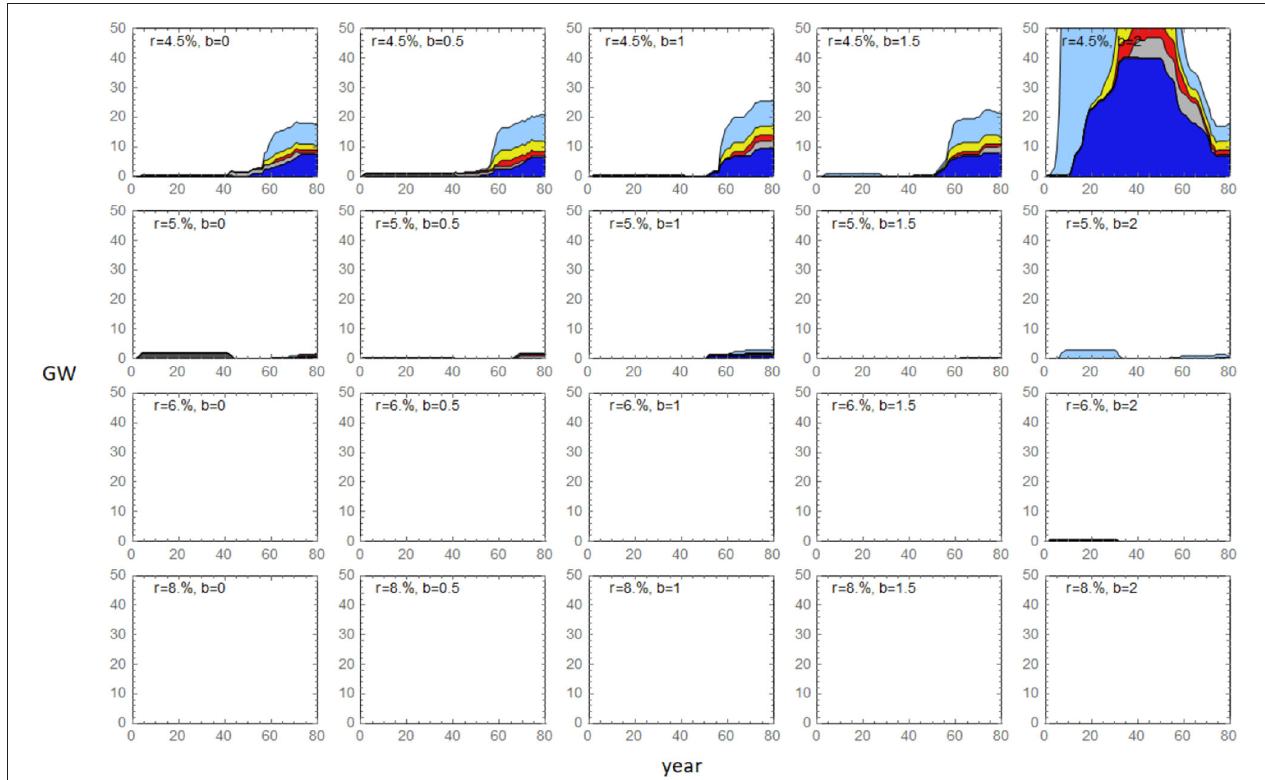
FIGURE 11 | Capacity mix of individual agents when financial feedback module is not implemented, which means an agent does not go bankrupt and can borrow 100% from the bank regardless of its financial situation.